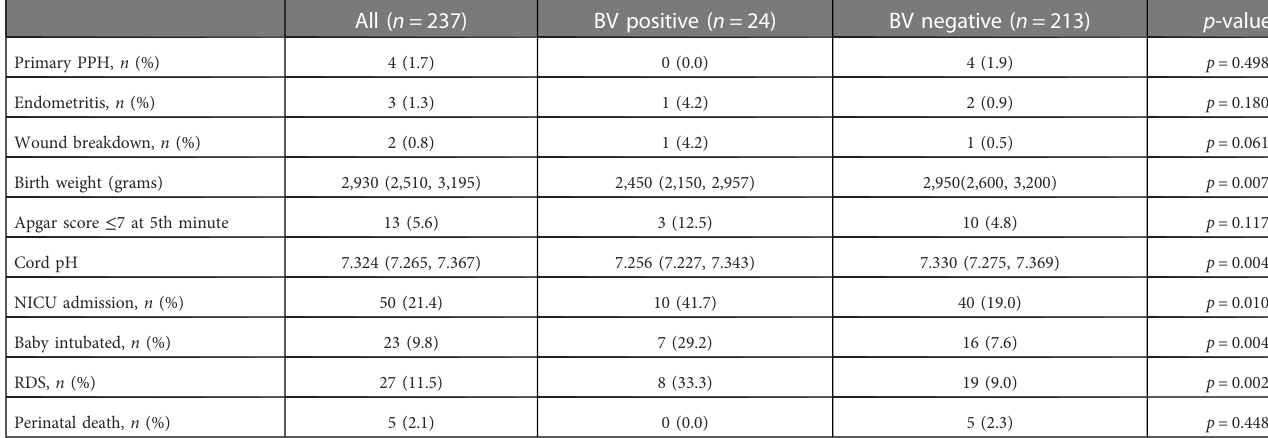
TABLE 3 Maternal-fetal outcome according to bacterial vaginosis status.